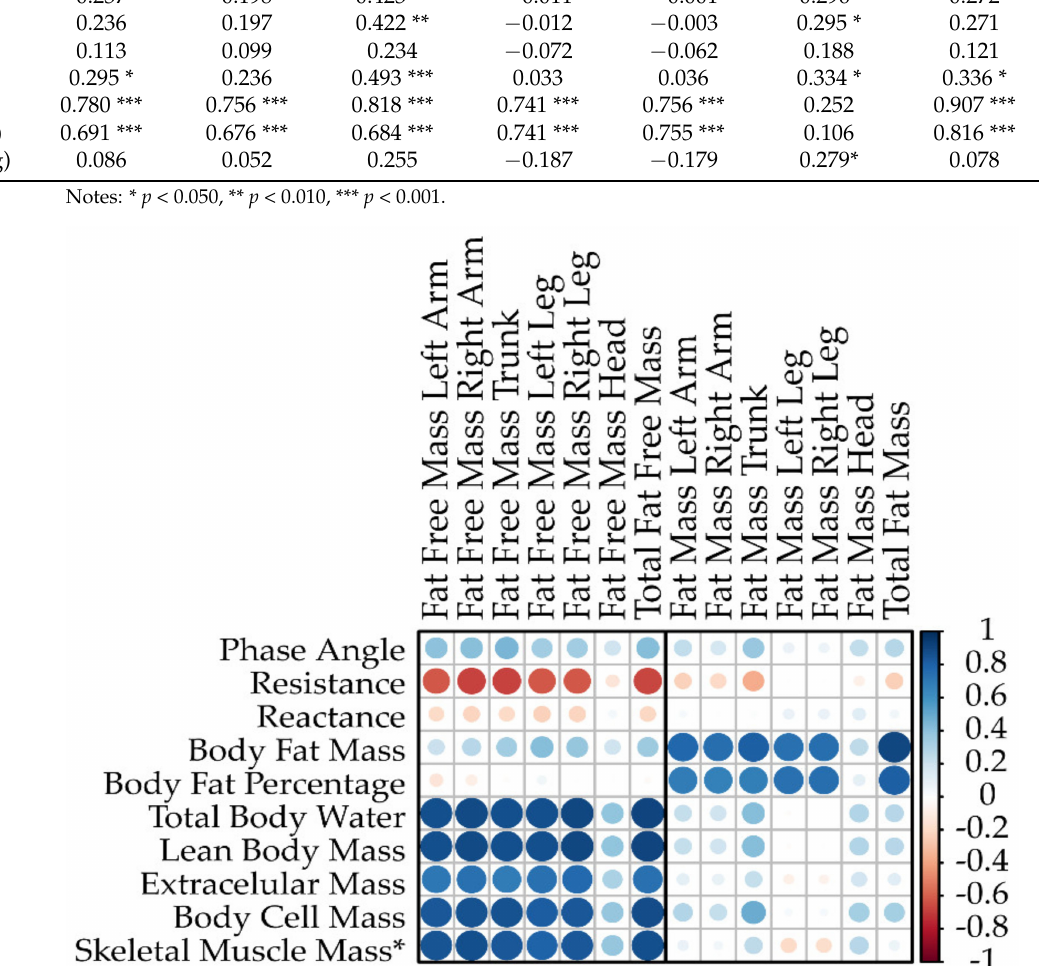
Figure 2. Correlation matrix for the BIA and DXA parameters: the red and blue dots correspond to negative and positive correlations, respectively. Small dots with light colors represent lower intensity correlations, and larger dots with darker colors correspond to higher intensity correlations. * As estimated by Janssen et al. (2000)